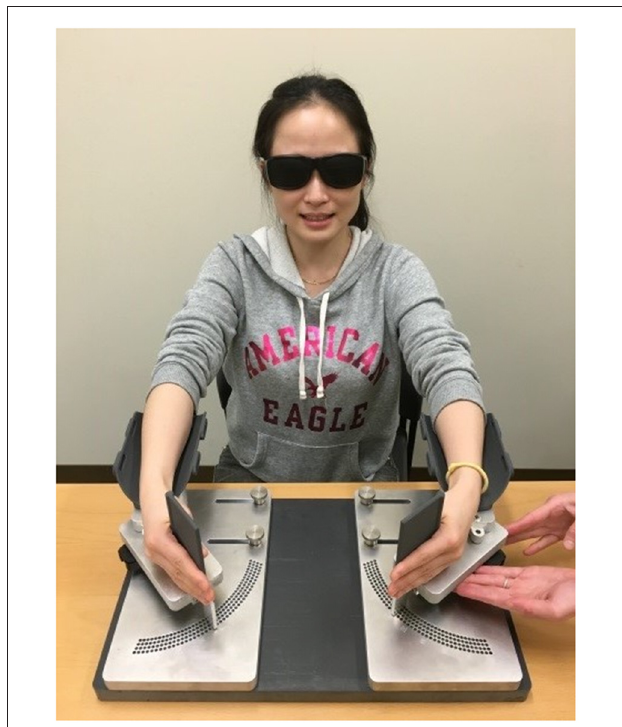
FIGURE 1 | Wrist bimanual manipulandum. Active ipsilateral and contralateral wrist position sense matching of a 15 ◦ reference wrist flexion position is performed with occluded vision. Consent was obtained from the individual for the publication of this